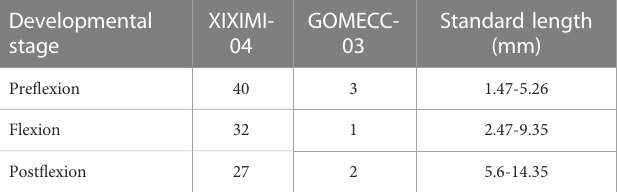
TABLE 1 Number of Bothus robinsi larvae sampled in two oceanographic cruises classi fi ed by developmental stages and standard length. Developmental stage